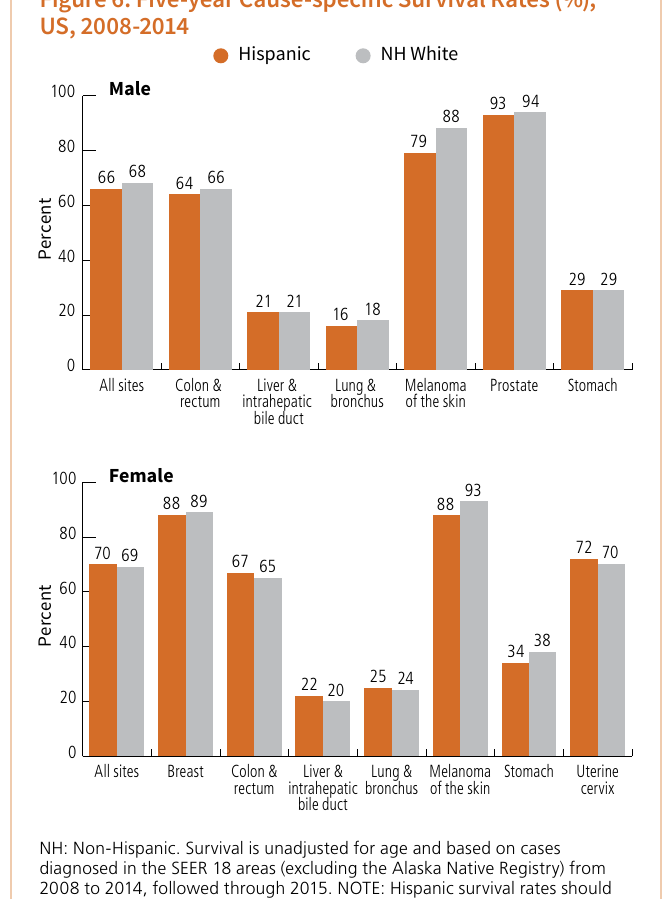
Figure 6. Five-year Cause-specific Survival Rates